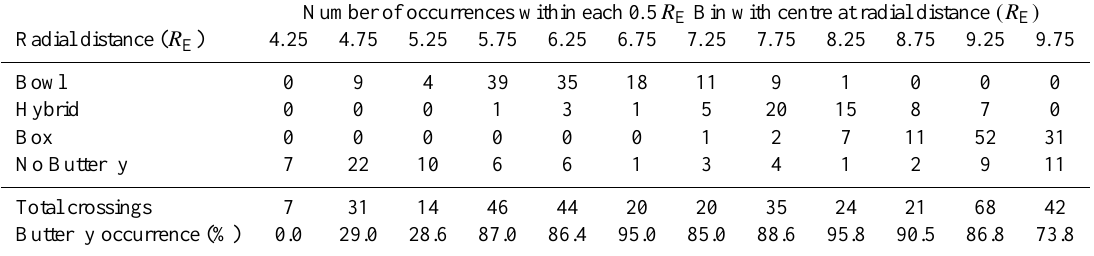
Table 1. The frequency of Butterfly PAD Shape is characterised by separating all of the crossing statistics into 0 . 5 R E bins and calculating the occurrence statistics as a function of radial distance. Along with Fig. 6, it can be seen that the bowl and box-shaped butterfly PADs occupy the inner and outer regions, respectively, of the sampled